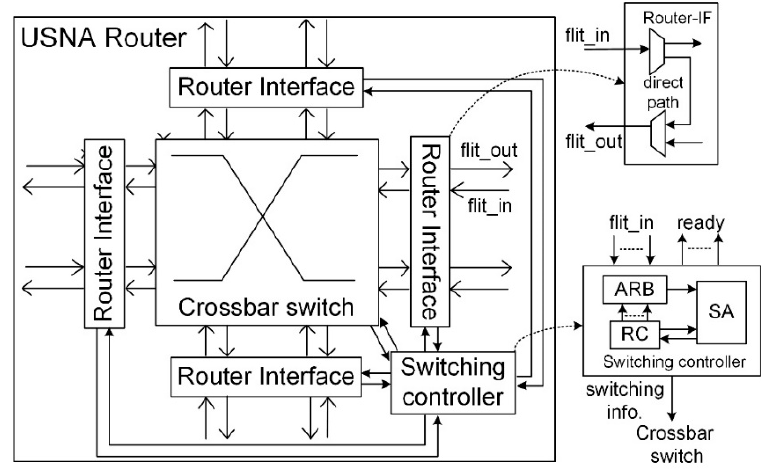
Figure 3. Block diagram of USNA router architecture with 8 ports.